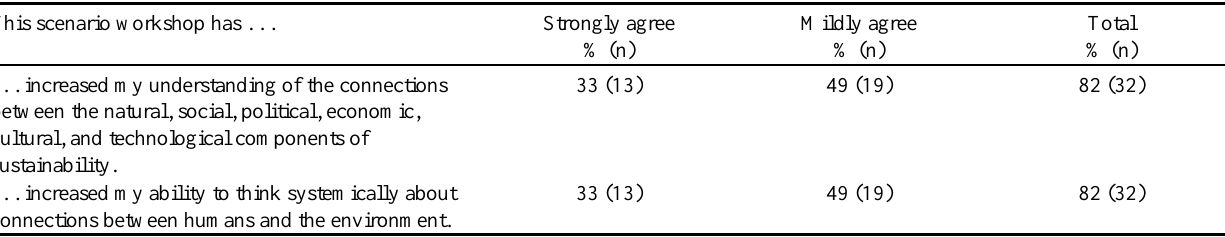
Table 2 . Systems thinking. Percentage of participants who 'strongly agree' (5 on 1 to 5 scale) and 'mildly agree' (4 on 1 to 5 scale) with the following survey statements (n = 39 surveys), and the total number who agree (either 4 or 5 on 1 to 5 scale). This scenario workshop has . .